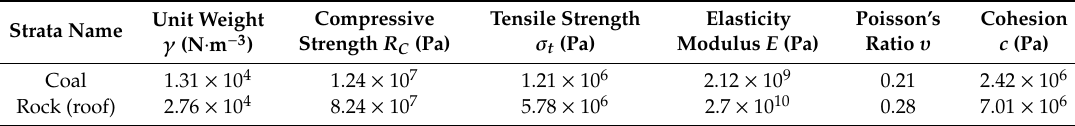
Table 2. Mechanical properties of the coal and